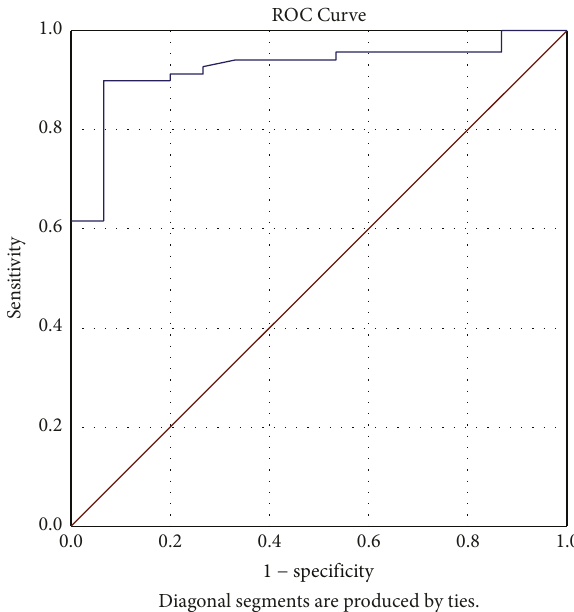
Figure 5: ROC curve depicting the discriminant function of S/ FP ∗ 10 (B) to be categorized as severe ARDS as per Berlin defi-